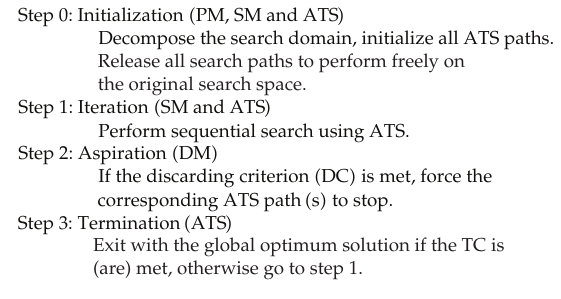
Figure 8: The MATS